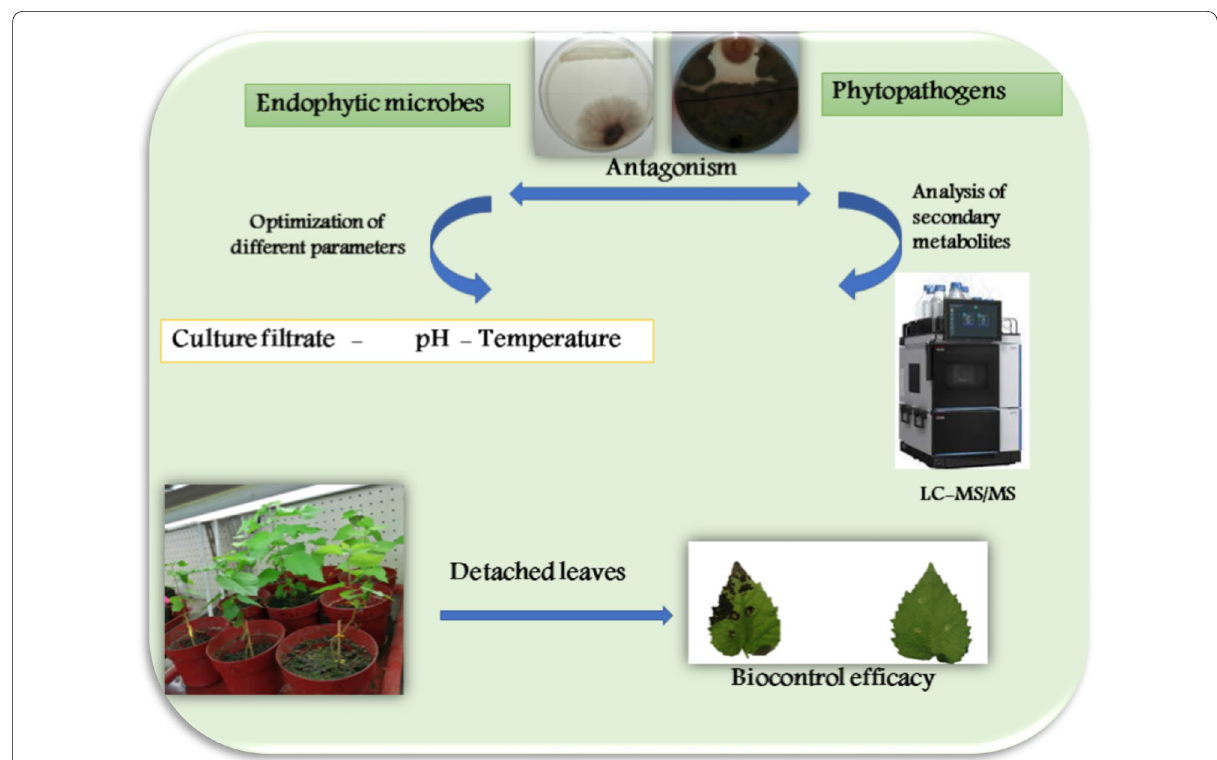
Fig. 1 Graphical abstract for the biocontrol efficacy of endophytic microbes under